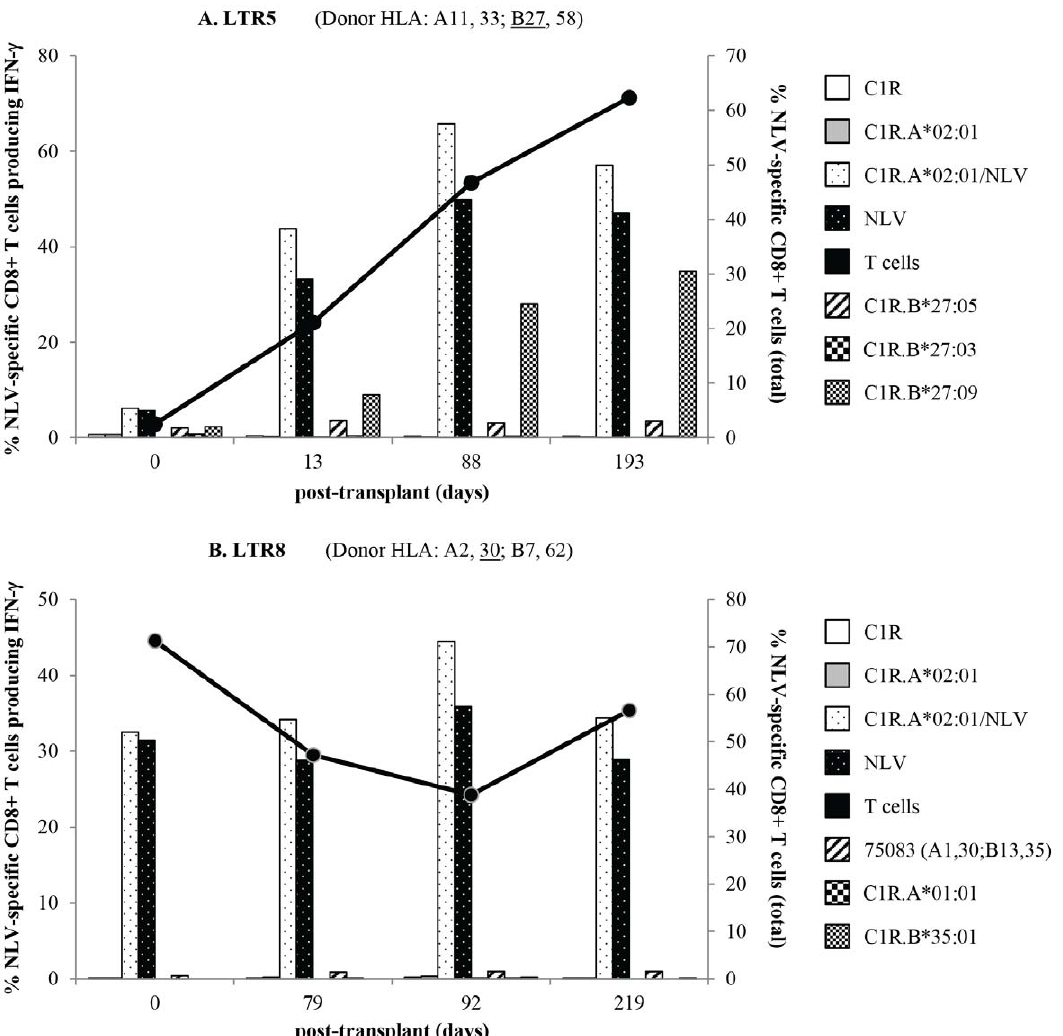
Figure 5. Longitudinal analysis of LTR cross-reactivity. NLV-specific cross-reactivity responses against B27 and A30 were measured against time after lung transplant in LTR5 ([A] top) and LTR8 ([B] bottom), respectively. Following a 6 hour ICS assay of day 13 T cell cultures, B*27:09 cross- reactivity significantly increased over time in LTR5, whereas A30 cross-reactivity remained stable post-transplant in LTR8. Percentages were based on IFN- c production of NLV-specific + CD8 + T cells. The secondary axis represents the percentage of NLV-specific CD8 + T cells gated on total CD8 + T cells (circles). (Figure 6A). A clinically relevant active CMV reactivation was